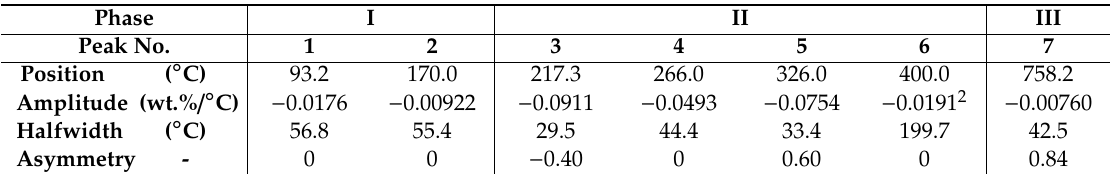
Table 2. Deconvolution parameters of the DTG curve for mass fraction of defecation lime in the sample equal to